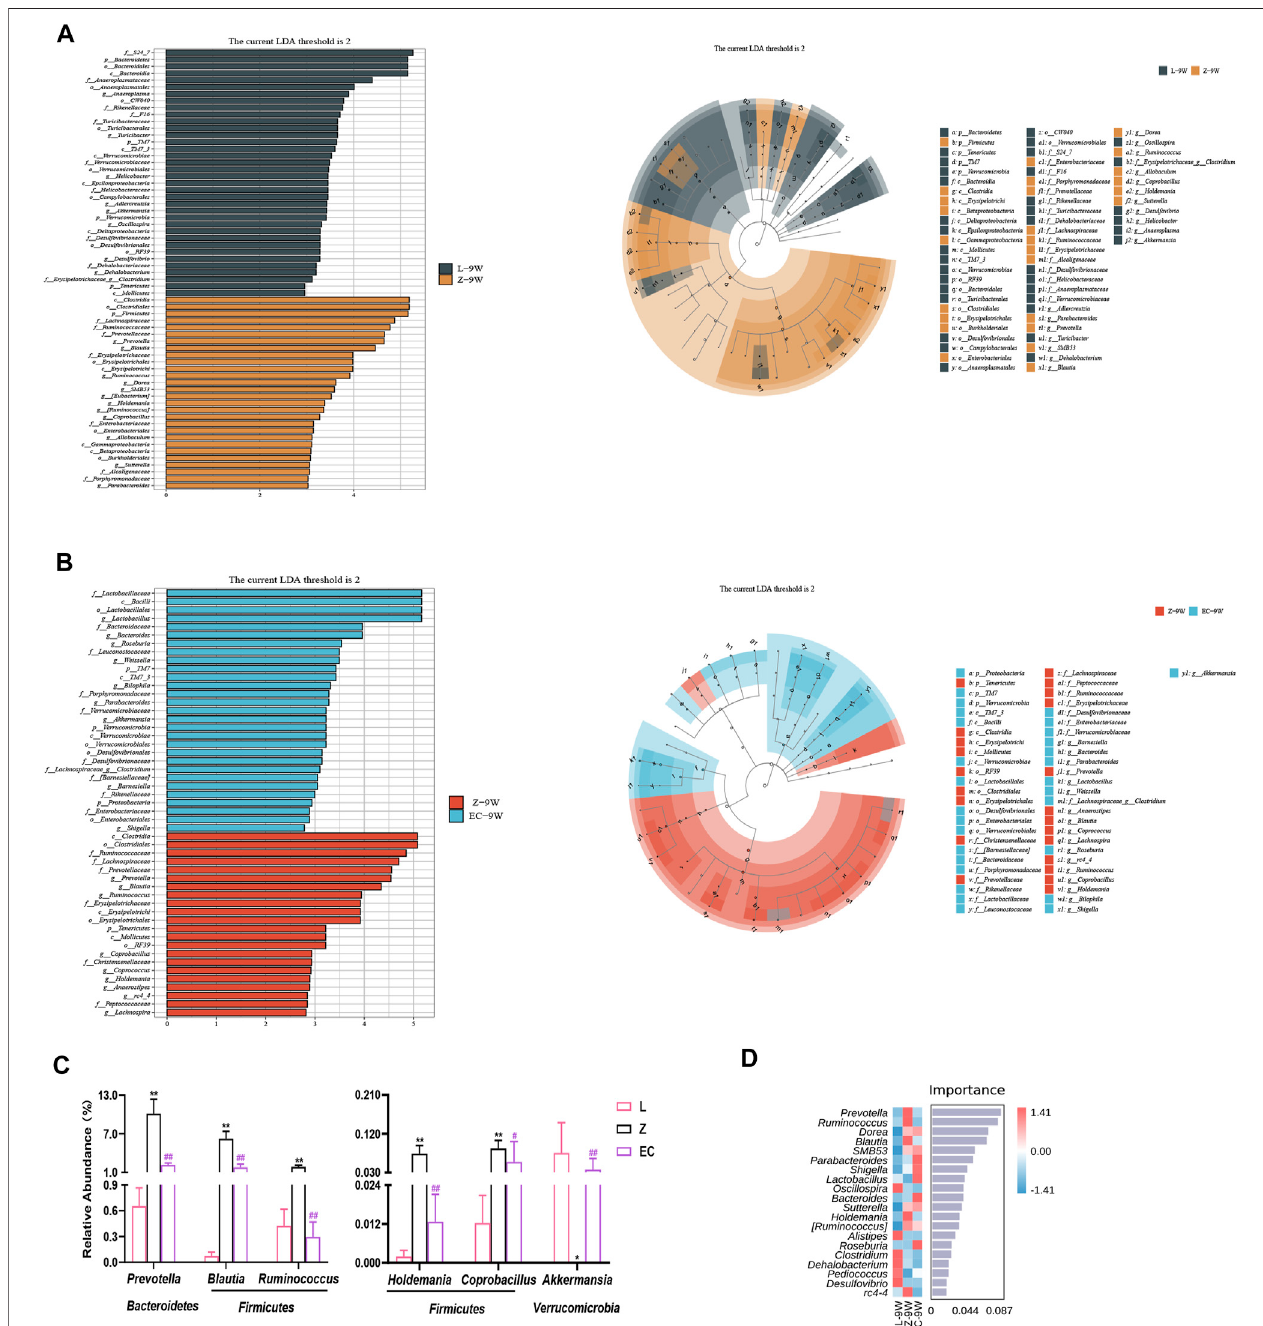
FIGURE 5 | ECD regulated the abundance of biomarkers at the genus level of gut microbiota in ZDF rats. All three groups were at 9 weeks of age. (A) LDA value distributionhistogram andcladogramofbiomarkers betweengroupsLand Z.( B )LDA valuedistributionhistogram andcladogramofbiomarkersbetweengroupsZand EC. LDA score threshold > 2 in (A) and (B). (C) Relative abundances of Prevotella , Blautia , Ruminococcus , Holdemania , Coprobacillus , and Akkermansia among three groups. The p -value was determined by LEfSe analysis. (D) Random forest analysis of differential gut microbiota. The intensity ofcolorsrepresents the abundance distribution of gut microbiota in each sample (red, the corresponding abundance was higher; blue, the corresponding abundance was lower).